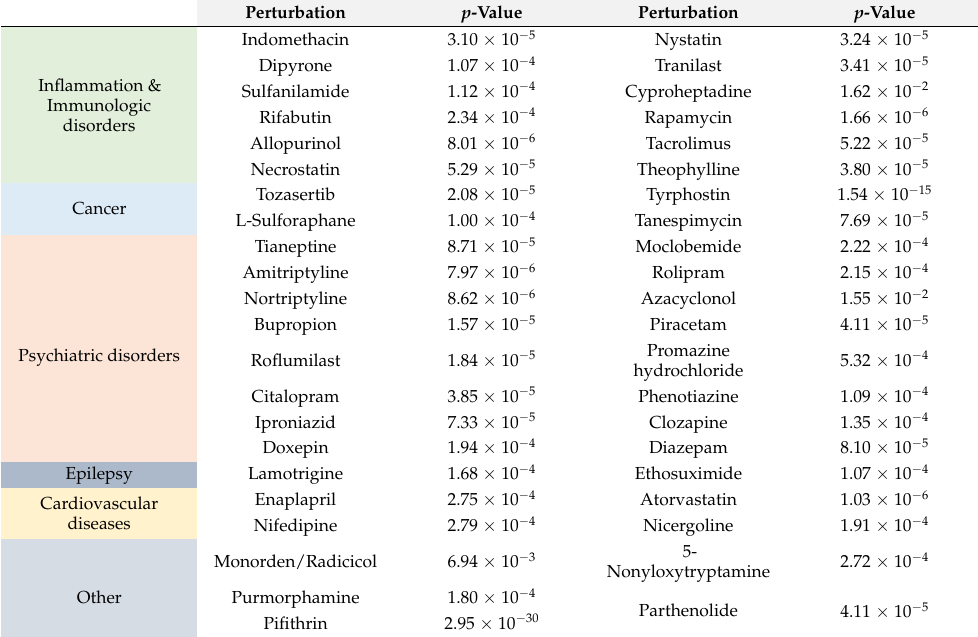
Table 1. List of the most enriched “repurposable” drug candidates with a potential to reverse apoptotic CGNs transcriptomic